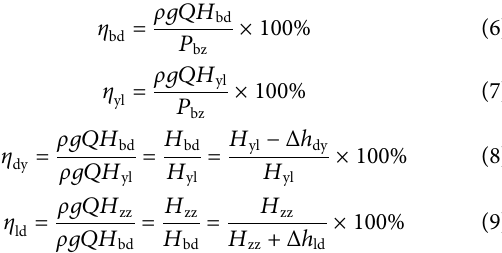
Frontiers in Energy Research |